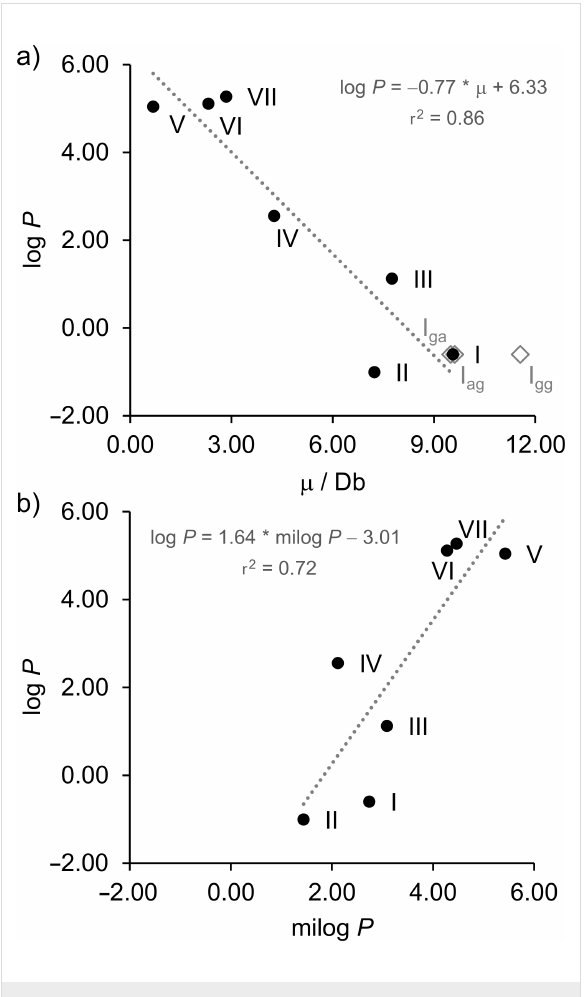
Figure 5: Correlation between the experimental log P of agrochemi- cals I – VII and a) dipole moment (for I , μ is used as a weighted aver- age of the conformers I gg , I ag , and I ga ), and b) predicted log P (milog P